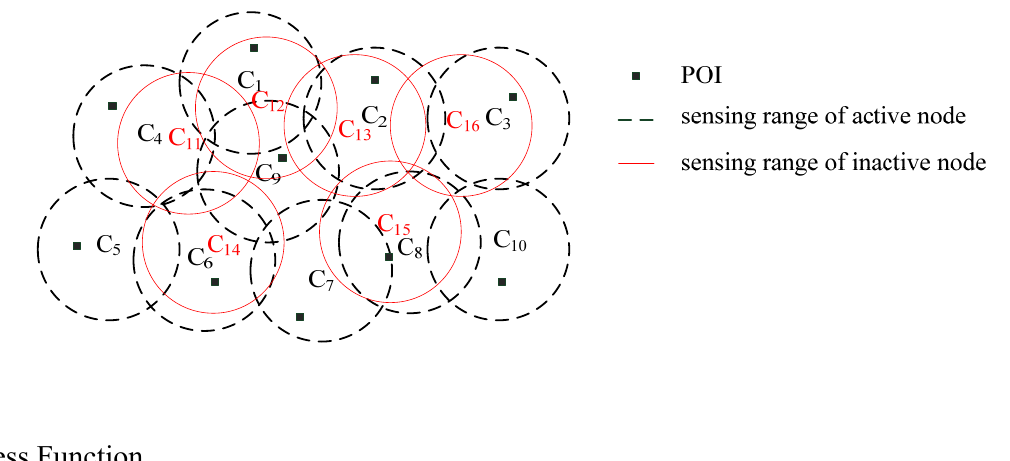
Figure 5. Illustration of sensing coverage in a CWSN for environmental sensing application. In this case, 16 nodes are activated to cover 10